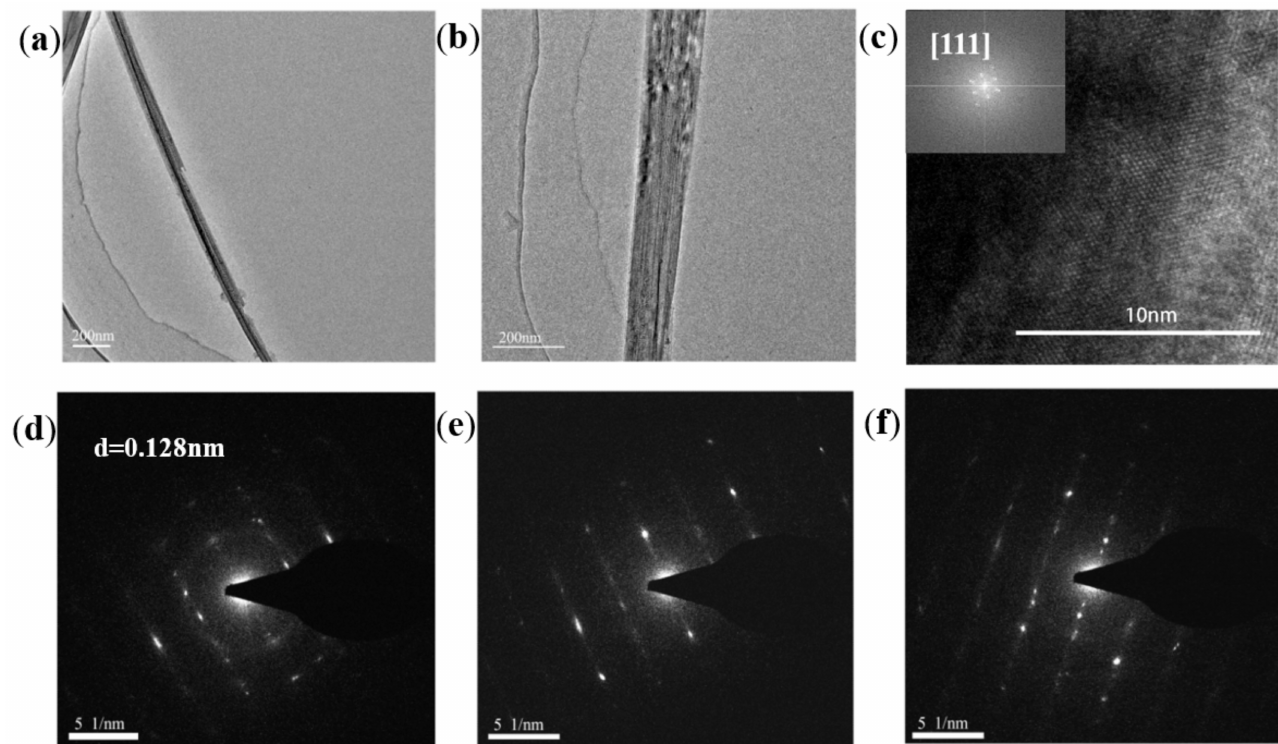
Figure 7. ( a , b ) The results of Sn 2 CoS alloy nanowires without AAO template at 200 nm scale by TEM. ( c ) The image of the Sn 2 CoS by HRTEM. ( d – f ) The SAED pattern of the Sn 2 CoS single-crystal structure recorded along the [111] crystal